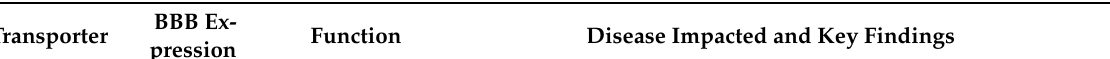
Table 1. Summary on the influence of inflammatory conditions and diseases on the expression and functionality of the BBB drug